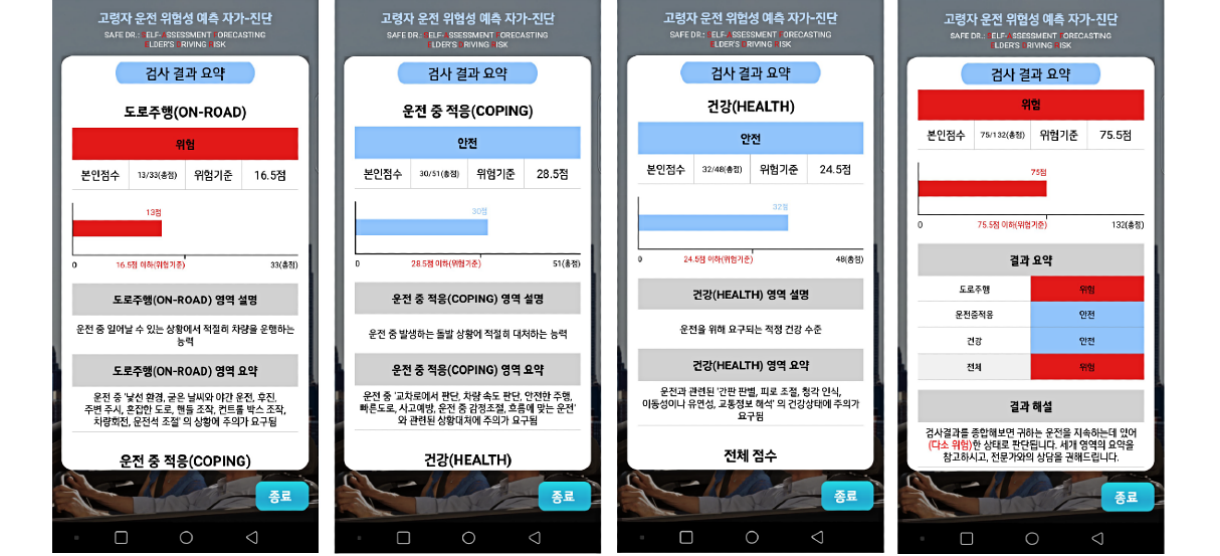
Figure 2. Screenshot of test results in the Android app. Displayed are subarea, total test results (classification of risk or safety in driving, graph of scores against reference points), and information requiring